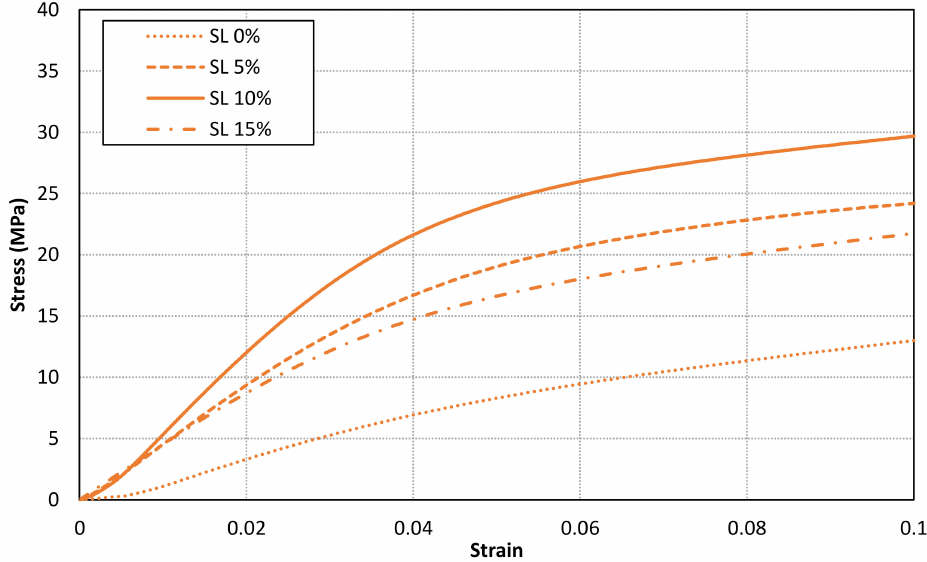
Figure 12. Stress-strain curves for a representative compression sample for each solid load content for Y